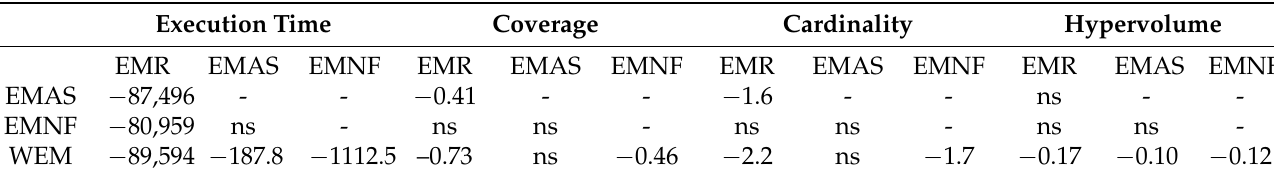
Table 3. The estimated difference in the average performance between the row and column algorithms for the metrics execution time, coverage, cardinality, and hypervolume. Only results statistically significant at 95% were calculated (ns, no statistically significant result). For the execution time metric, negative values indicate superiority for the algorithms in the rows. For the other metrics, negative values indicate superiority for the algorithms in the